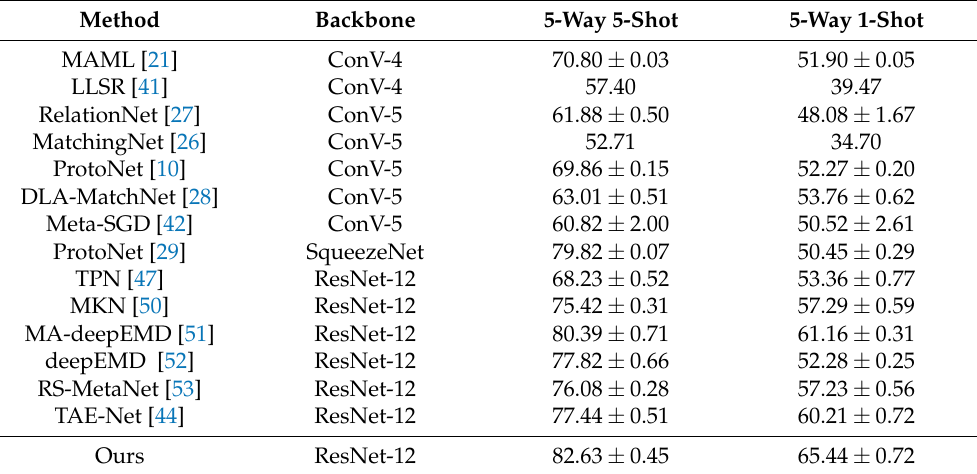
Table 5. The few-shot classification accuracies with 95% confidence over 600 episode intervals in the UC Merced